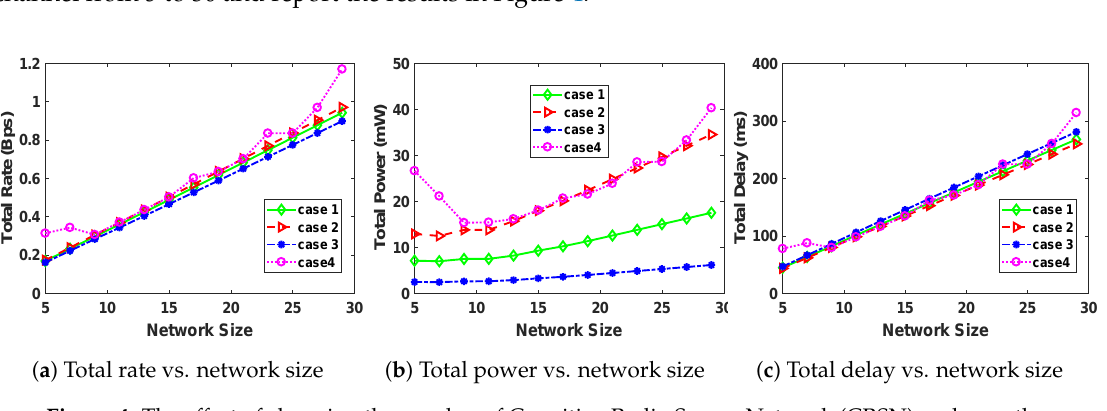
Figure 4. The effect of changing the number of Cognitive Radio Sensor Network (CRSN) nodes on the optimal solution of